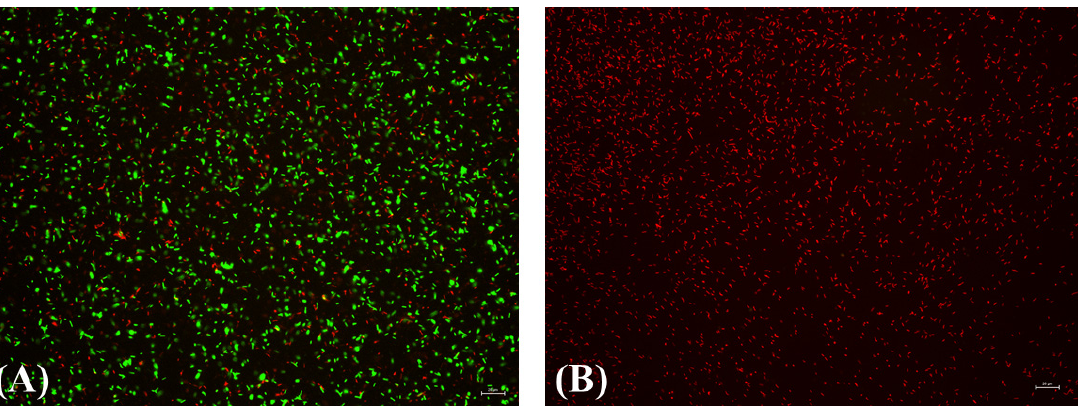
Figure 8. Typical fluorescence images of XfDD suspension in water for the untreated ( A ), and PAW treated ( B ) samples.